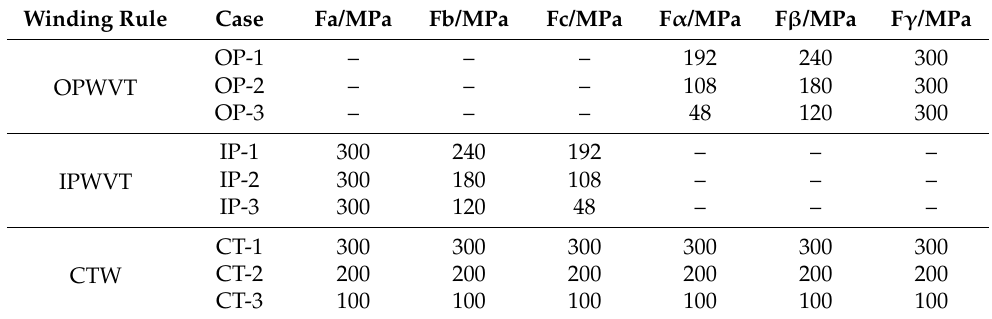
Table 2. Winding tension design scheme.